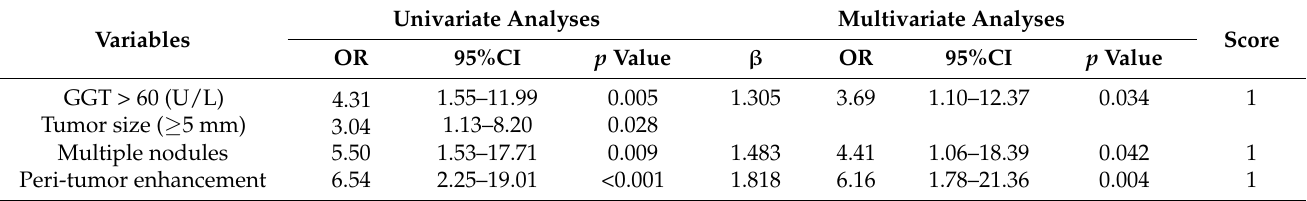
Table 2. Univariate and multivariate analyses of risk factors for the MVI of HBV-related cHCC-CCA. Univariate Analyses Multivariate Analyses